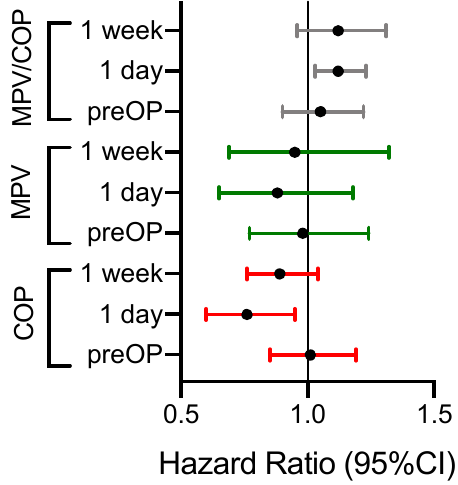
Figure 4. Forest plots of hazard ratios (HR) and 95% CI for overall survival of the platelet indices at